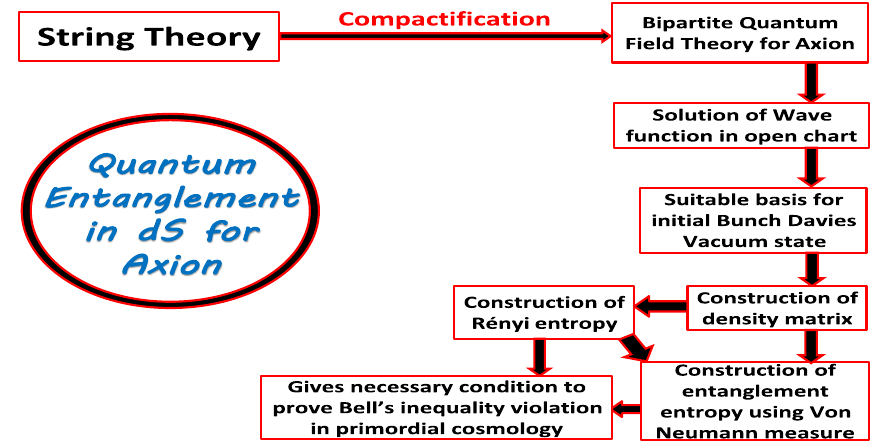
Fig. 1 Schematic diagram for the computation algorithm of entanglement entropy in de Sitter space due to